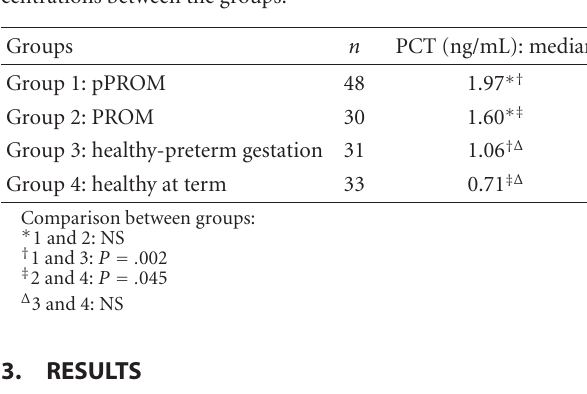
Table 2: Comparison of maternal plasma procalcitonin (PCT) con- centrations between the